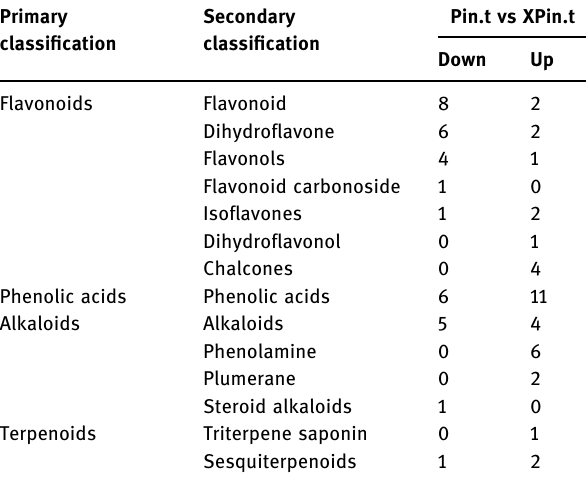
Table 3: Overview of the main di ff erentially accumulated secondary metabolites between Pin.t and XPin.t